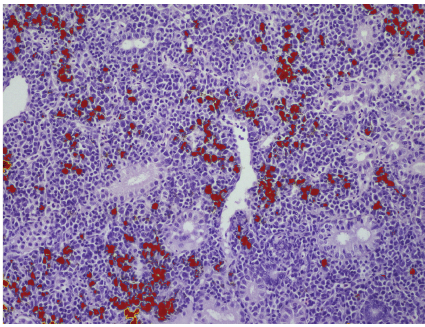
Figure 1: Rainbow trout ( Oncorhynchus mykiss ). Posterior kidney section in a trout from group F after software selected the pigmented area of